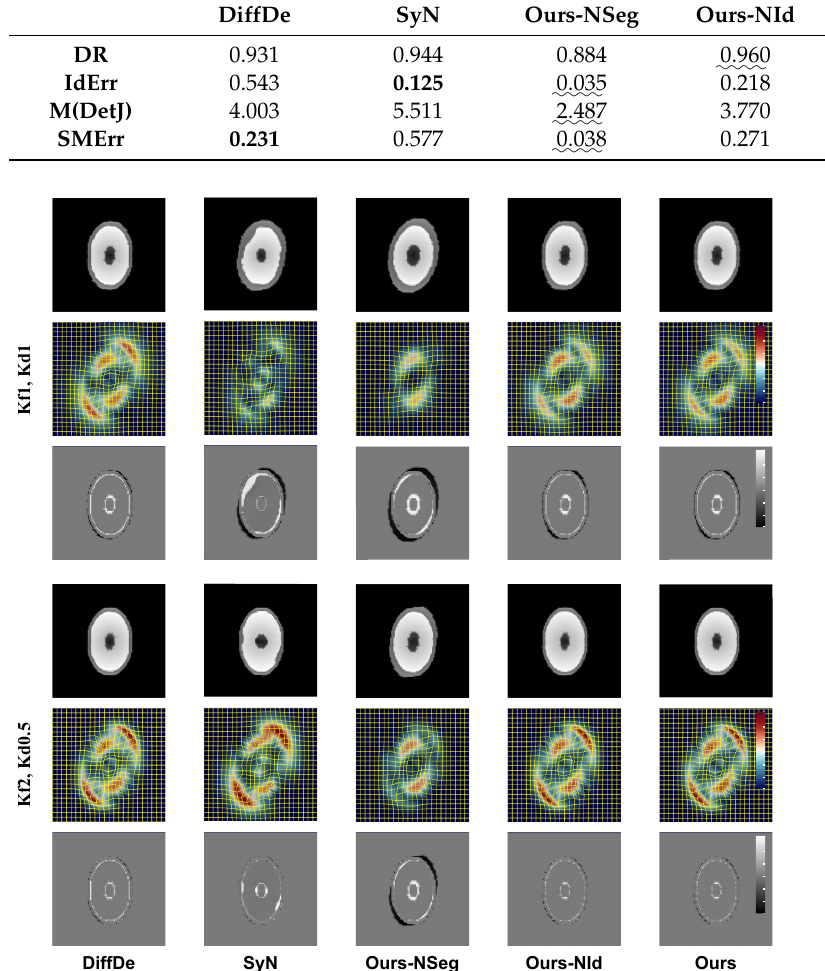
Figure 4. The qualitative results of Section 3.2 are shown. The figure has two parts, distinguishing between two kinds of smoothing parameters, i.e., Kf 1 Kd 1 and Kf 2 Kd 0.5. In each part, the three rows display the warped moving images, the deformation grids, and the residual images, respectively. Different columns are the results of different methods. The color of the deformation grids, whose scale bar ranges from − 4.5 to 5.8 pixels, represents the magnitude of the transformations. The color of the residual images, whose scale bar ranges from − 3.0 to 3.2, represents the difference between the intensity values of the fixed image and the warped moving